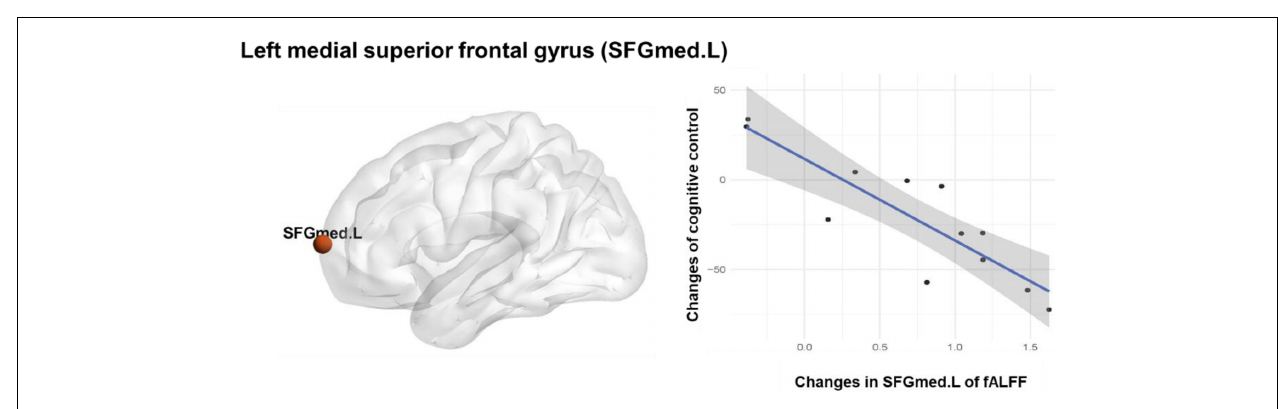
FIGURE 3 | Association between Inhibitory control and spontaneous neural activity. Pearson correlation and regression analysis of fALFF changes and inhibitory control changes in the TCC group.